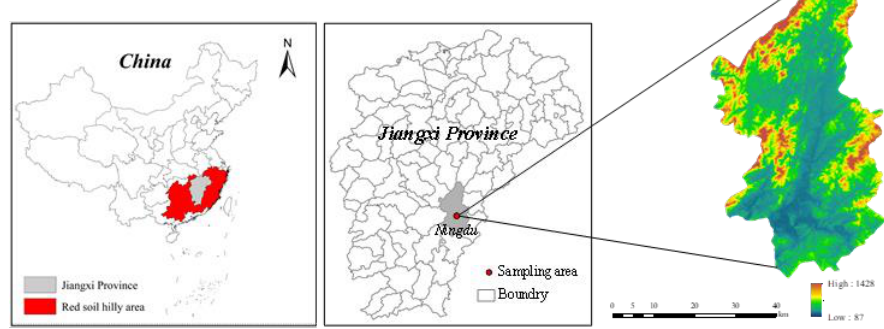
Figure 1. Location of study area.